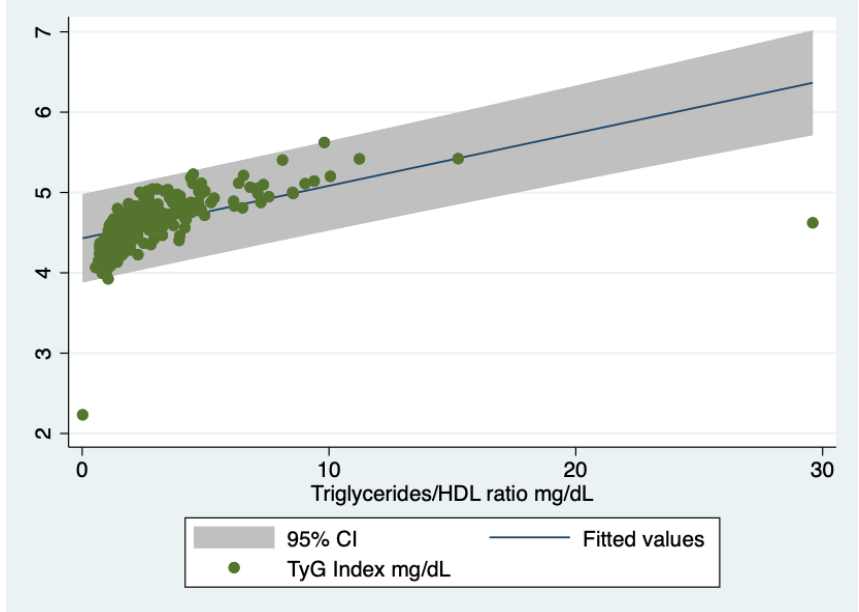
Figure 2. Prediction of the TyG Index by the triglycerides/HDL ratio. TyG Index, triglycerides/glucose index. HDL, high density lipoprotein. There are only two outliers.